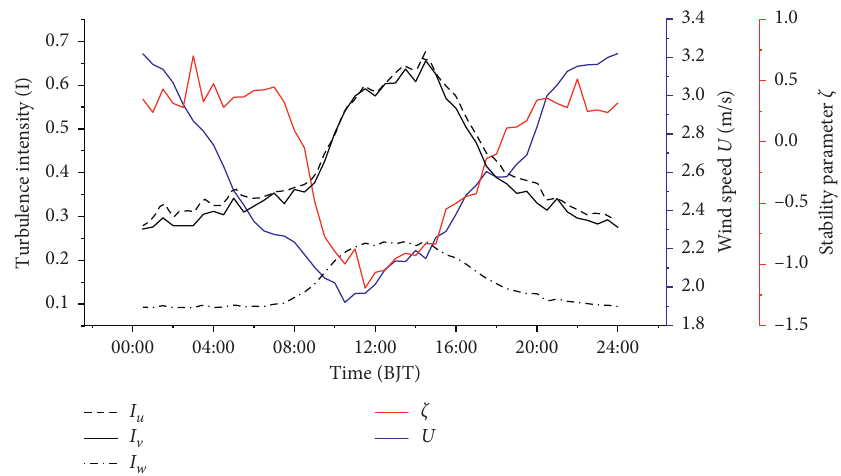
Figure 3: Average diurnal variation in annual turbulence intensity with wind velocity and stability. Table 3: Turbulence intensity of u , v , and w under different stability conditions and in different seasons. Turbulence intensity Spring Summer Autumn Winter I u 0.56 Unstable ( ζ < 0) Near-neutral (| ζ | ≤ 0 . 1